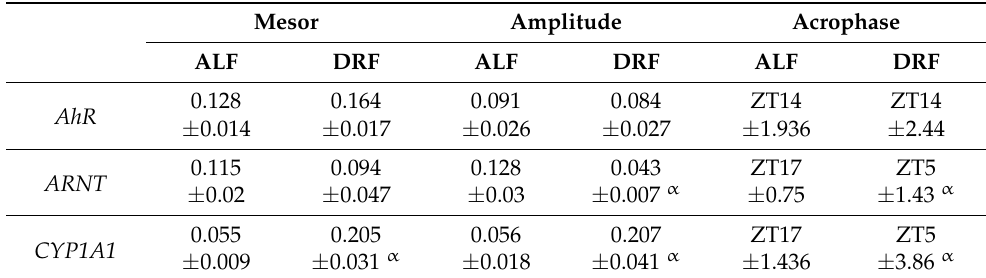
Table 2. Chronobiological parameters obtained by Cosinor analysis for the effects of DRF on AhR , ARNT, and CYP1A1